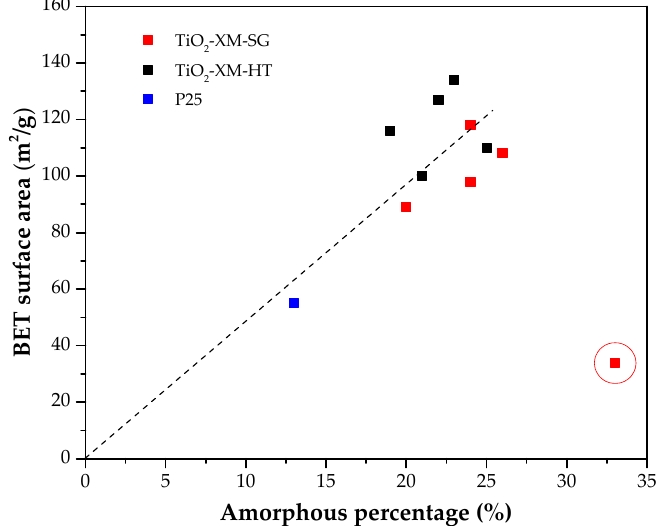
Figure 4. BET surface area vs amorphous percentage for the SG and HT photocatalysts and P25 titania. Attention should also be paid to the relationship between surface area and phase composition.